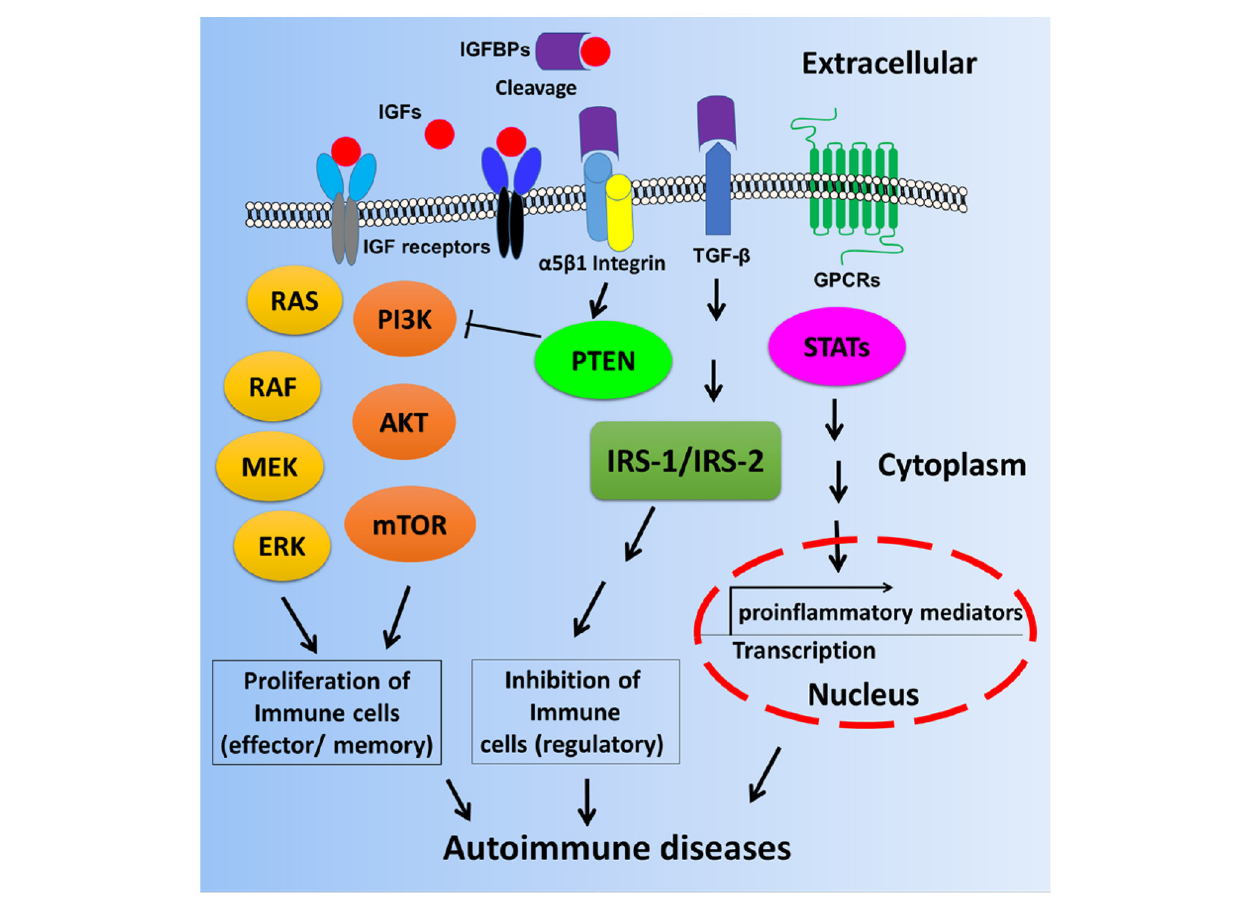
FIGURE 2 | Scheme of possible mechanisms by which autoimmune diseases are mediated by IGF-IGFBP signaling pathways. Immune cell proliferation may be partly dictated by IGF-IGFBP pathway. The inhibition of regulatory immune cells or the control of gene transcription of proinflammatory cytokines may be mediated by IGF-independent pathways such as IGFBP3, TGF- β , and GPCR etc. STAT: Signal transducer and activator of transcription including STAT1, STAT2, STAT3, and STAT4.